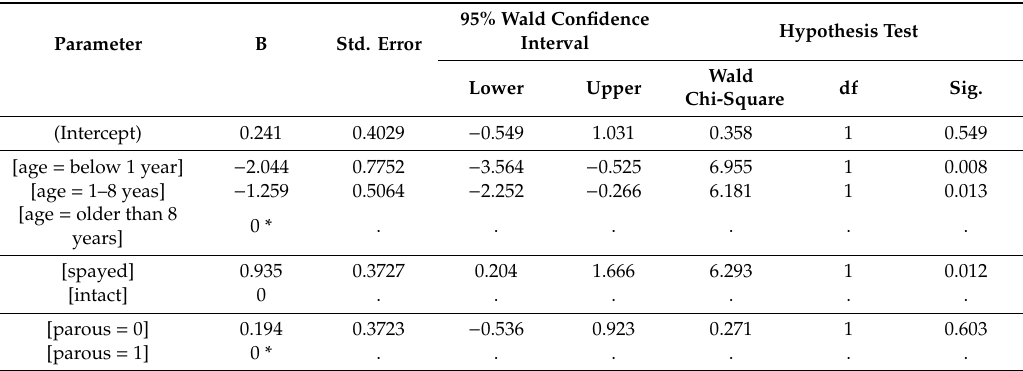
Table 5. Parameter estimates of the female dogs’ behavior with the puppies in association with their age, reproductive status, and parousness (did not have puppies or had puppies before). GzLM with binary logistics. * this parameter is set to 0 because it is redundant. B